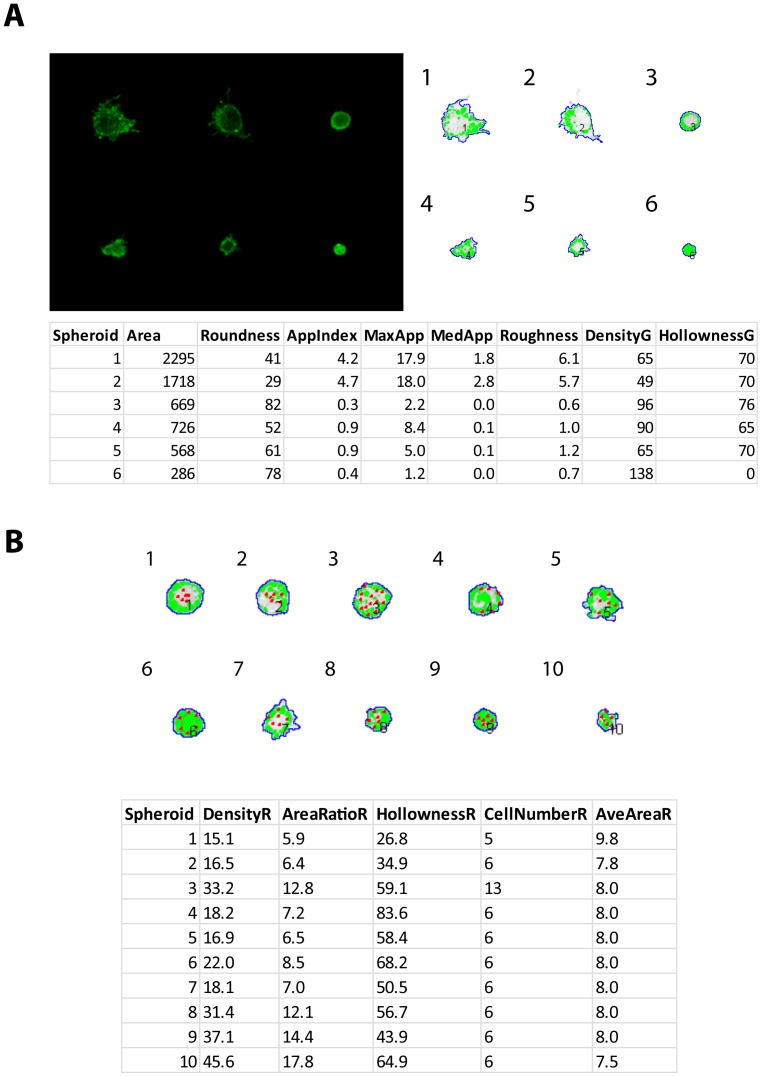
Evaluation of key parameters analysed by AMIDA.(A: left panel) Six representative PC-3 spheroids, all treated with different compounds in order to manipulate the morphology, stained for viable cells (Calcein AM) and imaged with spinning disk confocal microscope (5x objective). (A: right panel) The same spheroids segmented with AMIDA. The table in A shows numerical values appointed by AMIDA for selected morphological features. (B) Representative panel of PC-3 spheroids with red dots added by image manipulation in certain number and distribution to exemplify the power and preciseness of RGB functions (B: table).